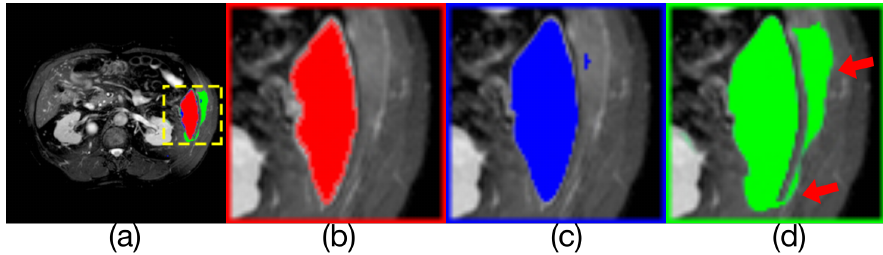
Figure 10. Comparison of model outputs and ground truth. ( a ) is composed of the other three figures above are stacked from top to bottom, where the predicted extra areas are clearly seen. ( b ) is the manually annotated result. The blue region in( c ) is the output of Render U-Net. The green region in ( d ) is the output of U-Net. Some areas with incorrect predictions are indicated with the red arrows in the figure.